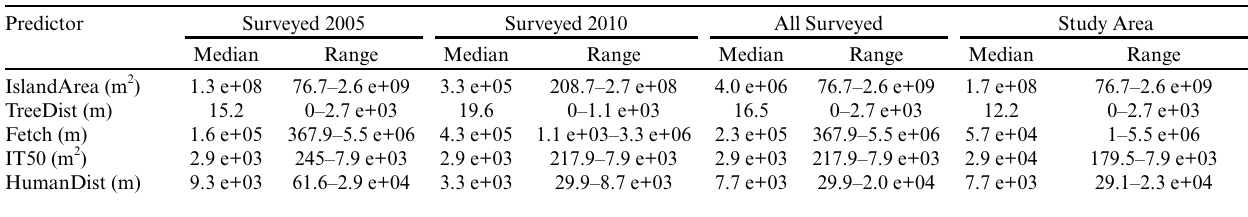
Table 3 . Range and median for continuous predictors retained in final models over different extents of study area. Values are scaled for readability. Surveyed 2005: shoreline surveyed in 2005 (south of Juan Perez) by Canadian Wildlife Service; All Surveyed: all surveyed shoreline including 2005 and 2010 survey conducted by Laskeek Bay Conservation Society in Juan Perez and Laskeek Bay; Study Area: includes all surveyed shoreline and unsurveyed shoreline within the study area (southeastern Haida Gwaii).